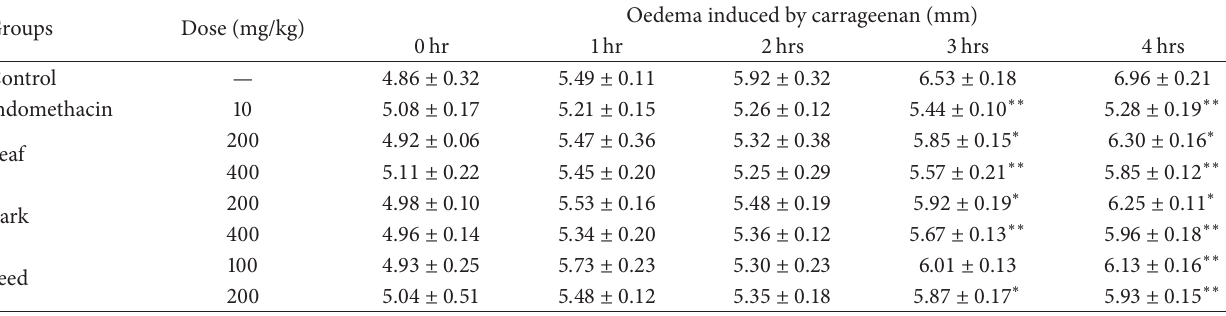
Table 4: Anti-inflammatory effect of ethanol extracts of C . australe on carrageenan induced paw oedema in rats. Groups